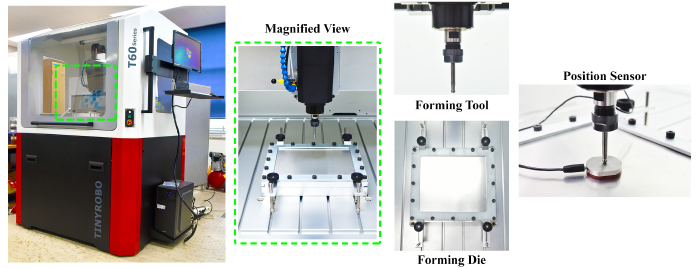
Figure 1. Experimental setup of single-point incremental forming